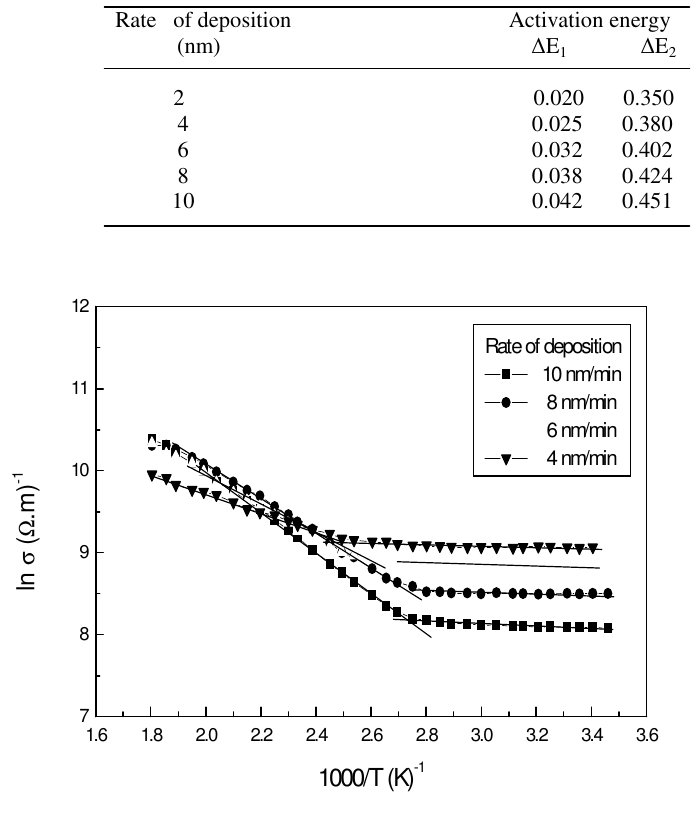
Figure 3. Plot of ln σ Vs 1000/T for ITO thin films prepared at various deposition